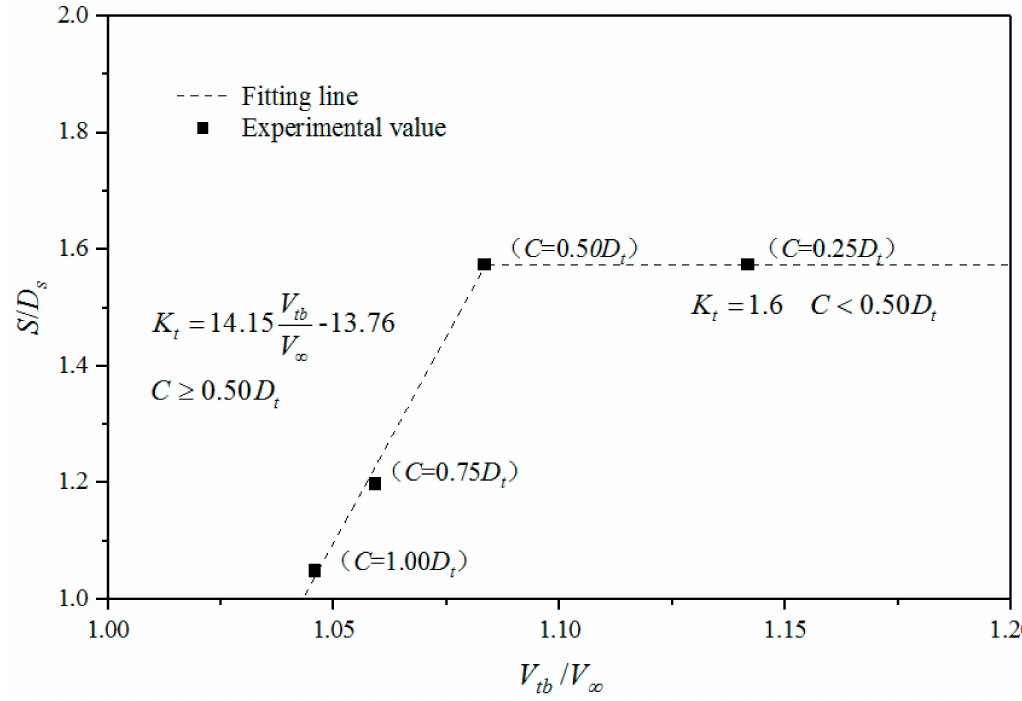
Figure 16. The relationship between the tip-bed velocity and tidal turbine scour